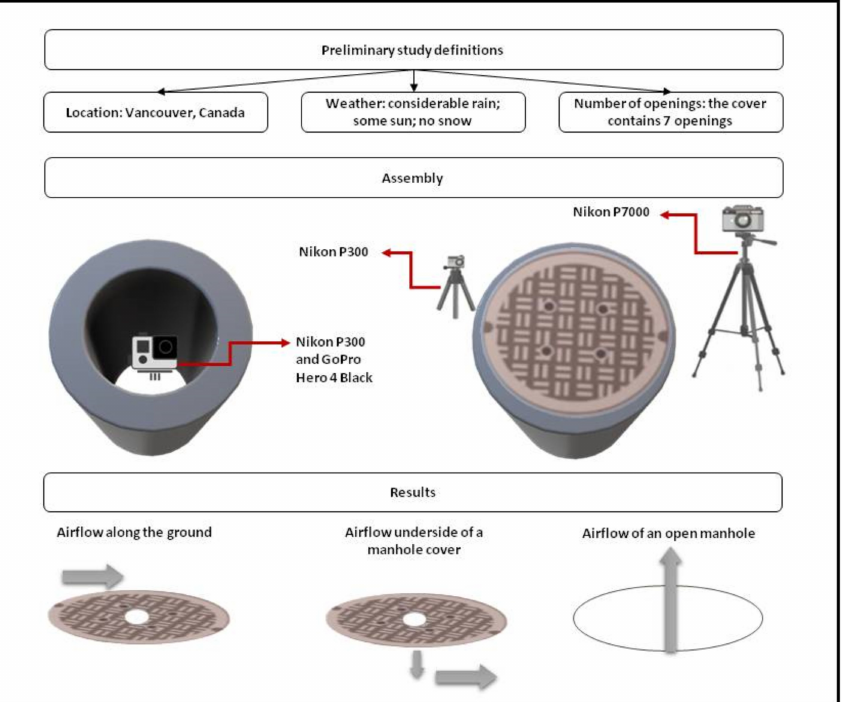
Figure 1. This diagram summarizes key information associated with work performed during this investigation. It also provides a ready reference for understanding parameters obtained during analysis using